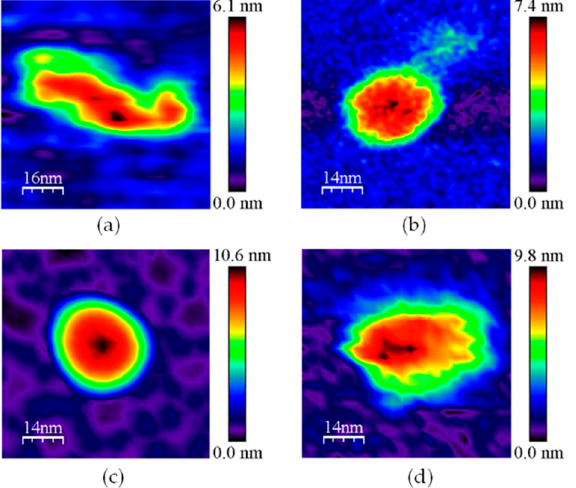
Figure A2. Representative 2D images for subpopulation 3 in ( a ) GvFTTR; ( b ) CaFFTR2; ( c ) GvDDOR; and ( d ) GvFFTR_ Δ tail samples. Samples measured in PBS pH 7.0. Scan sizes for the images are 70 nm × 70 nm, except for ( a ), 80 nm × 80 nm.